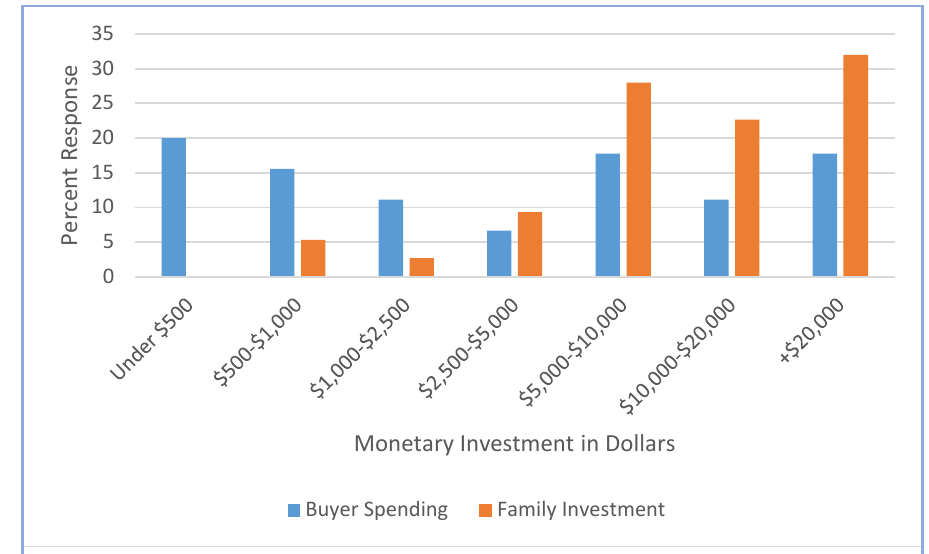
Figure 1. Percentage of Monetary Spending of Livestock Animal Sale Buyers Compared to Percentage of Monetary Investment by Youth Raising Livestock Animals for the